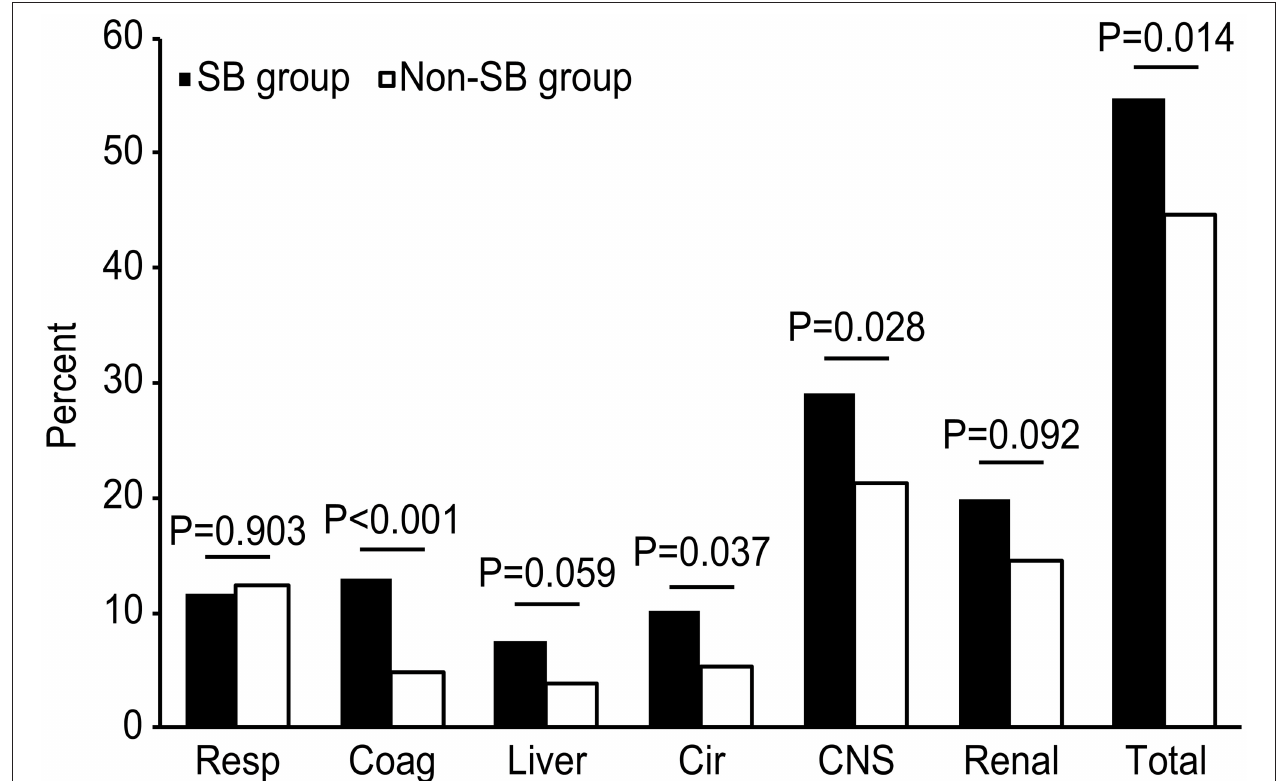
FIGURE 2 | Comparison of the incidences of newly d/eOD between the SB and non-SB group after PSM. The chi-square test was used to compare the percentages of d/eOD between the two groups. d/eOD, developed or exacerbated organ dysfunction; composite of newly d/eOD was defined as an increase in SOFA score ≥ 2 over the baseline (SOFA score in the first 24h) of one organ at least within 7 days of ICU admission. Resp, respiration; Coag, coagulation; Cir, circulation; CNS, central nervous